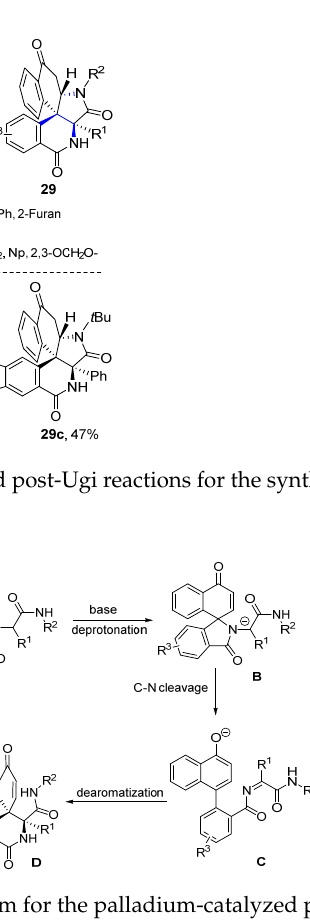
Scheme 16. Proposed mechanism for the palladium ‐ catalyzed post ‐ Ugi reactions.